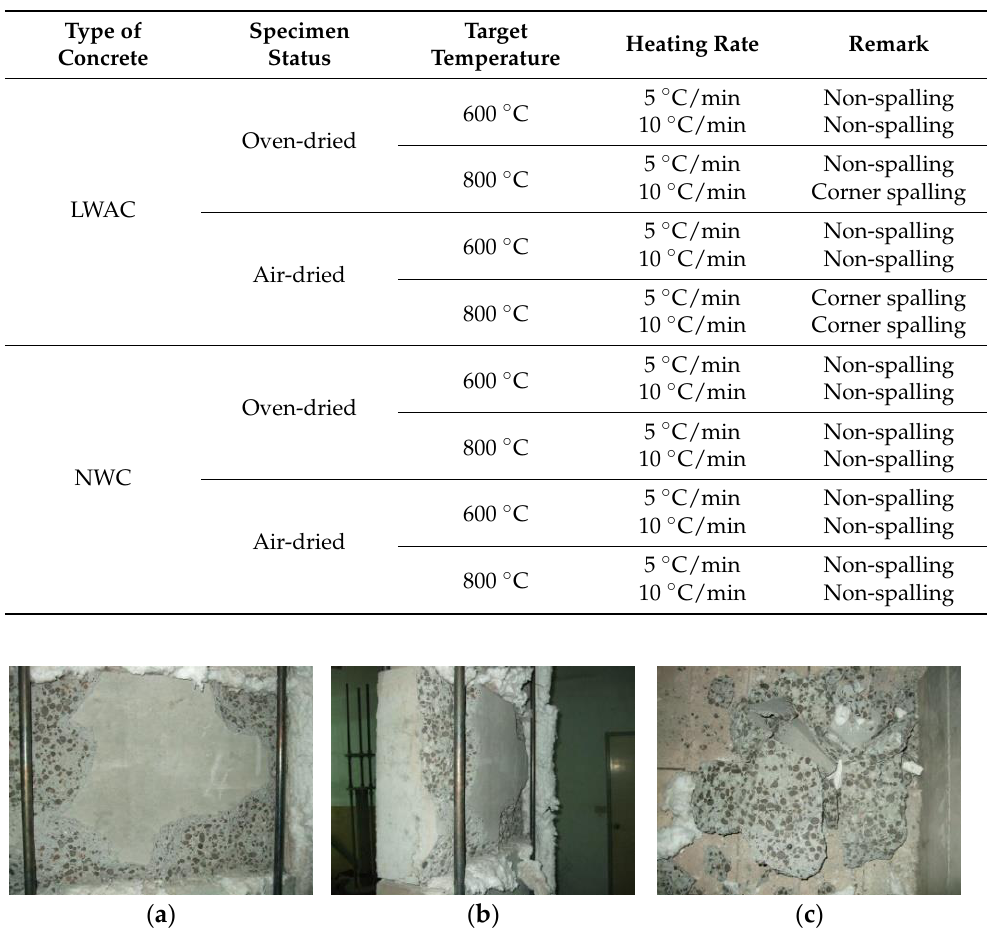
Table 6. High-temperature test results.